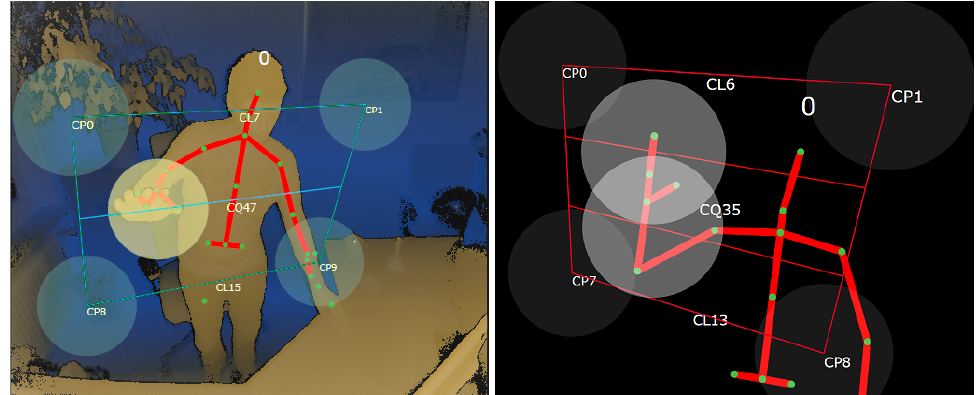
Figure 6. Examples of real-time visualization and interaction with ColPoint objects. Collisions between a ColQuad and body SpacePoints are shown.